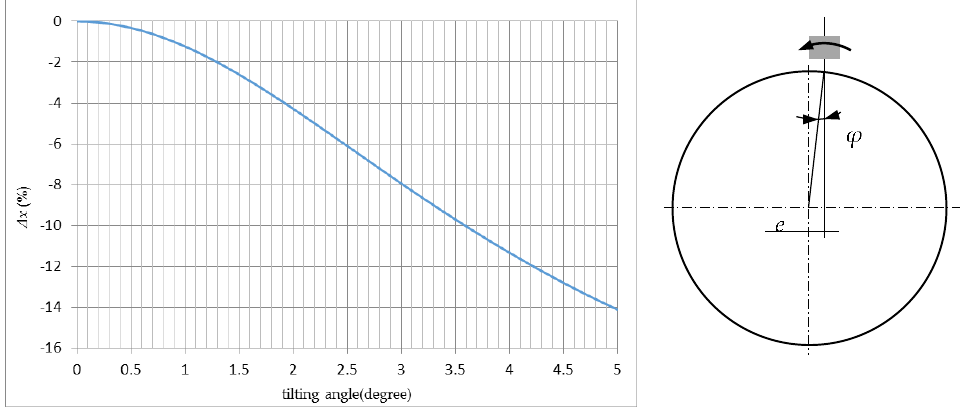
Figure 3. Measurement errors (signal change) with tilting angle.